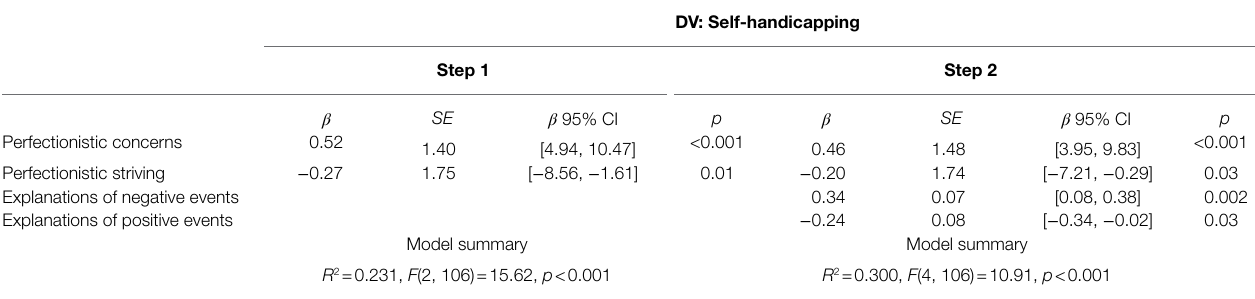
TABLE 2 | Hierarchical regression analysis predicting self-handicapping.